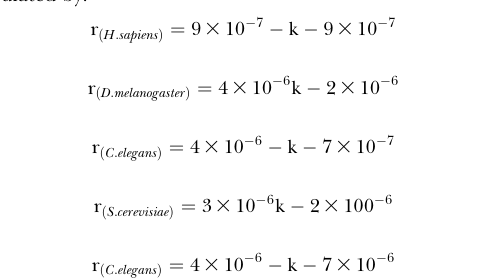
Table S1. The Estimated Rate Calculated Is Robust to Variation in Accuracy of the Datasets Used To test for a possible bias of the experimental method used in determining protein interactions, we divided the interactions of the human dataset into three subsets, as defined in the Human Protein Reference Database: yeast two-hybrid, in vitro studies such as GST pull-down, and in vivo studies such as co-immunoprecipitation.